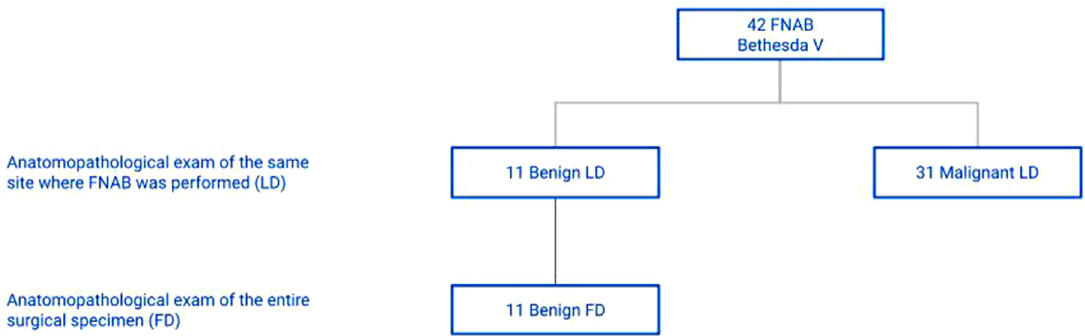
Fig. 4. Anatomopathological exams of patients categorized as Bethesda V.